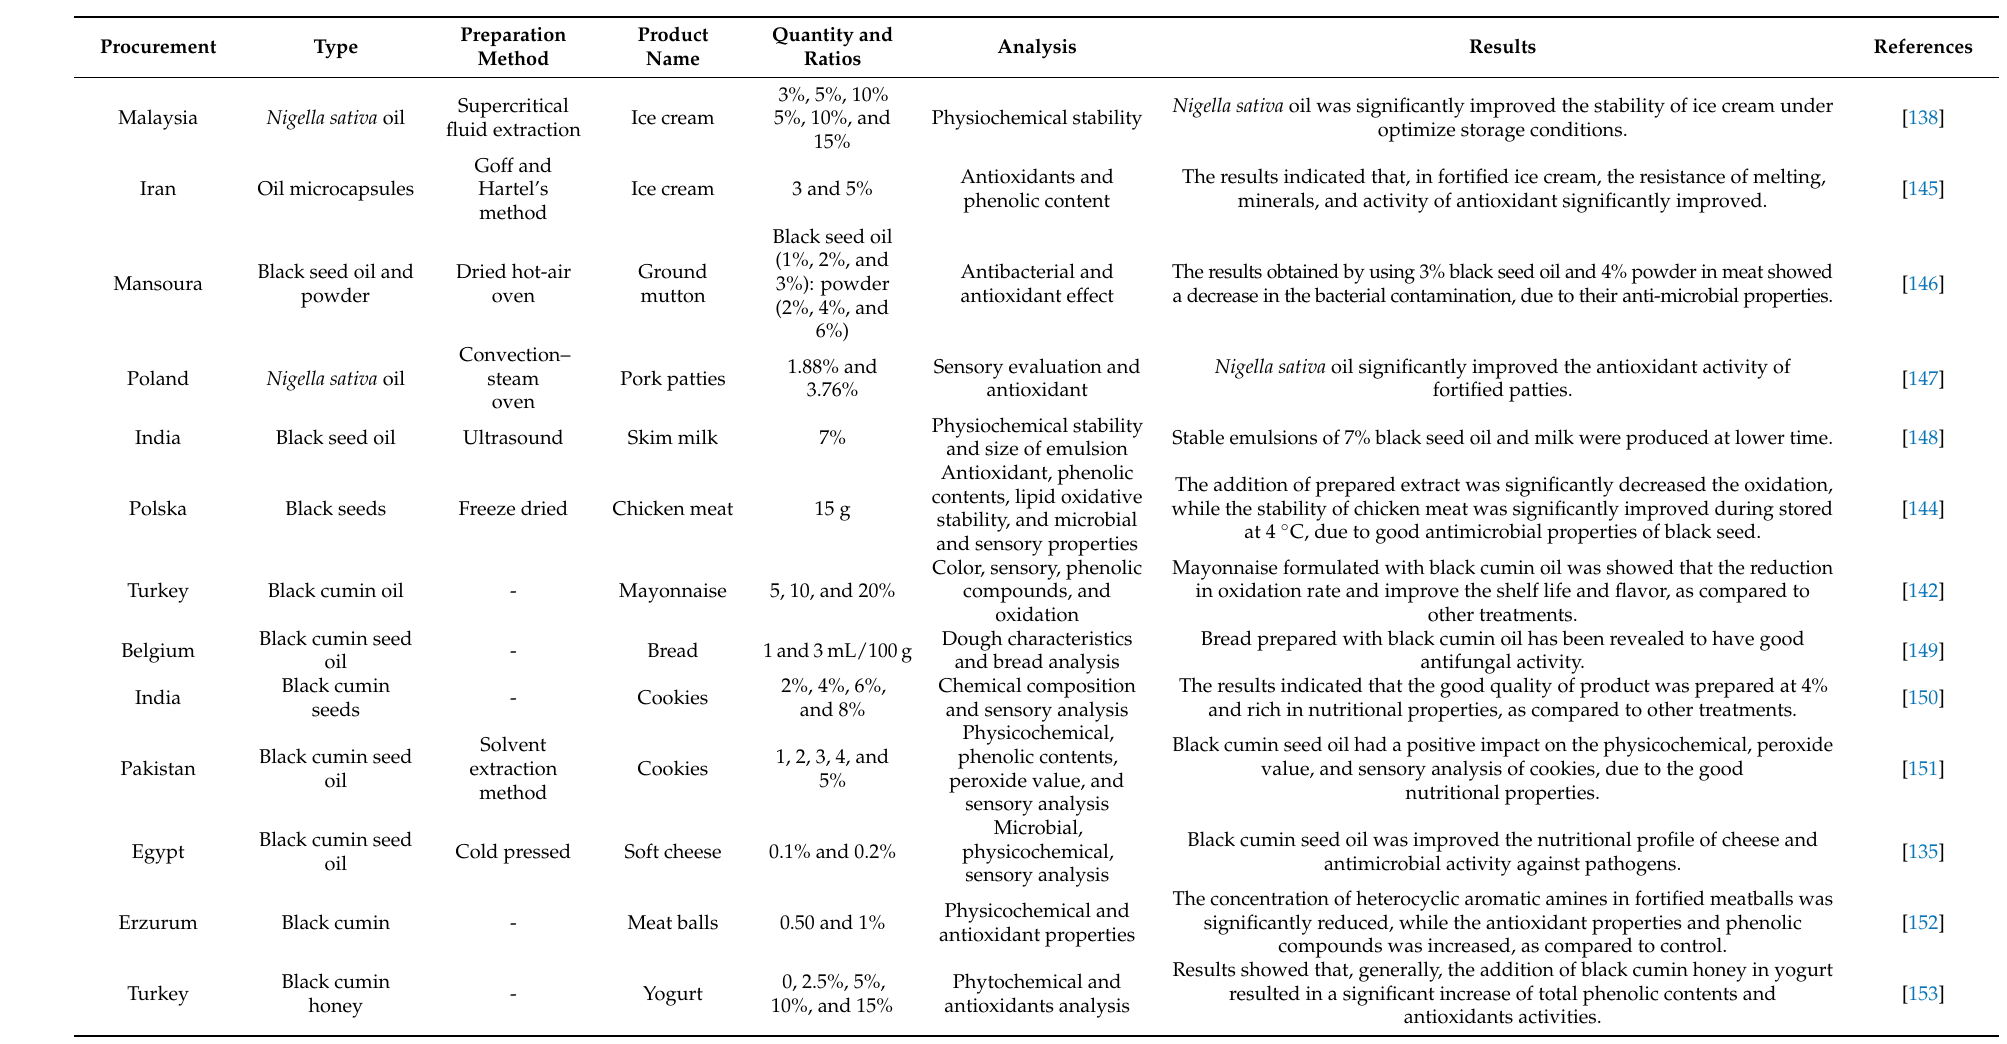
Table 4. Food applications of black seed and their